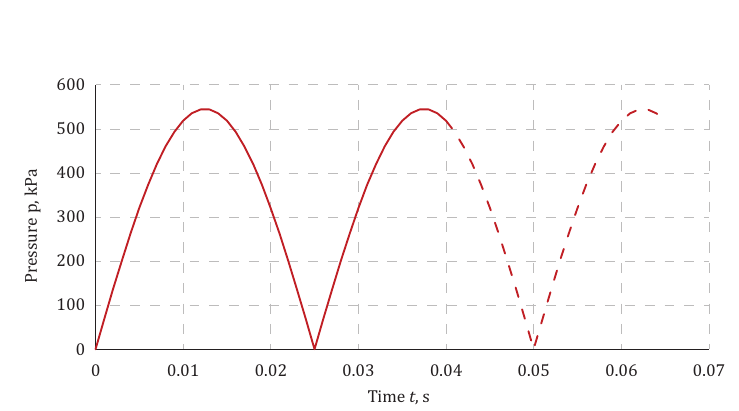
Figure 3. Time-depending surface